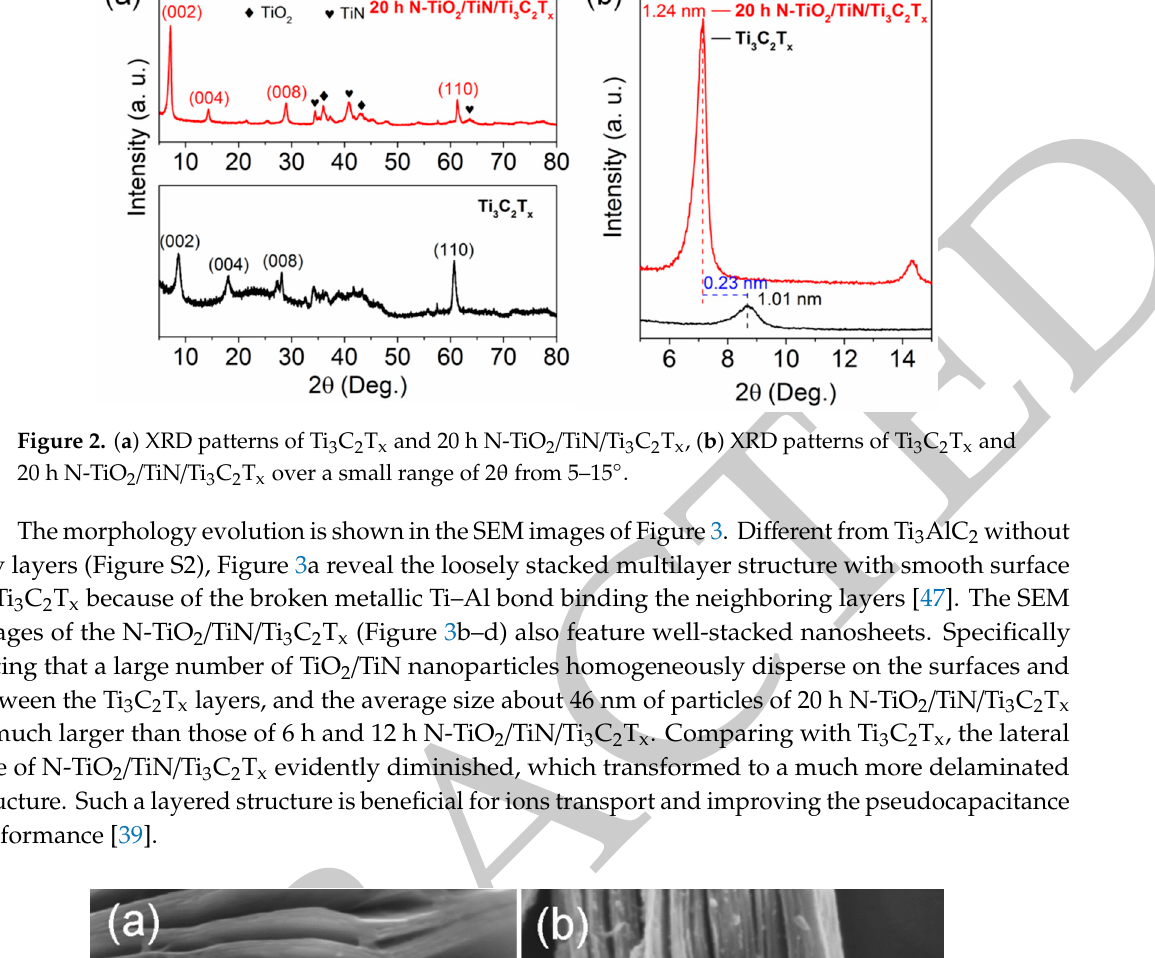
Figure 3. SEM images of ( a ) Ti 3 C 2 T x , ( b ) 6 h, ( c ) 12 h and ( d ) 20 h N-TiO 2 /TiN/Ti 3 C 2 T x .